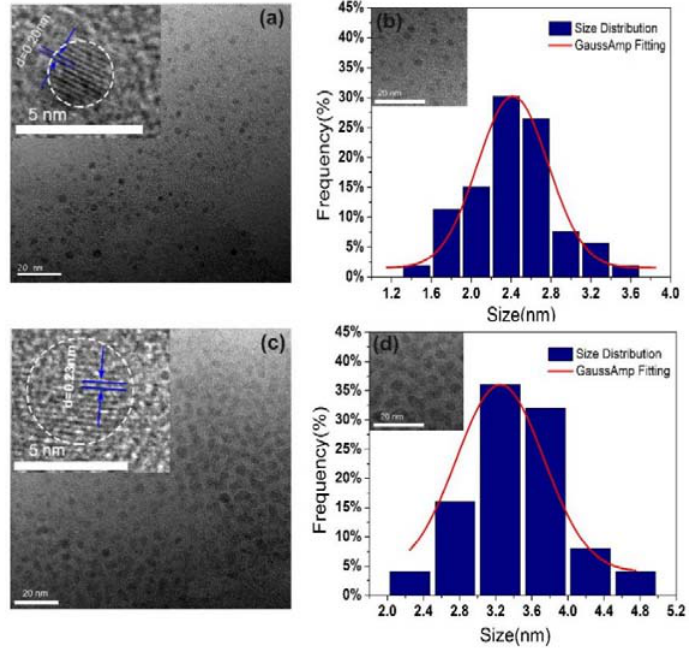
Figure 2. ( a , c ) Transmission electron microscopy (TEM) and high-resolution TEM (HRTEM) (insert) images of CQDs (1:1) and CQDs (1:2); ( b , d ) The size distribution and local-enlarged TEM image (inset) of the CQDs (1:1) and CQDs (1:2).